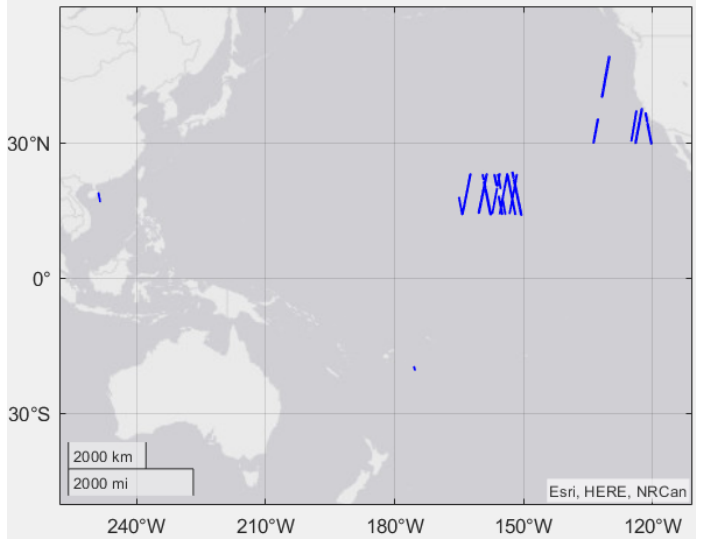
Figure 1. The map of collected GF3-02 SAR ocean imagery location.